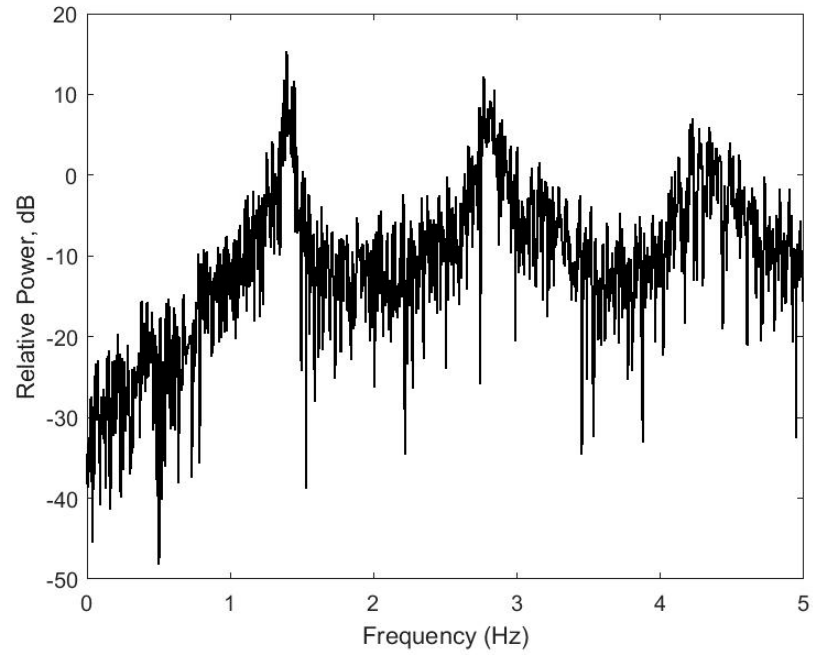
Figure 5. Fourier Transform of pressure signal from a halter.